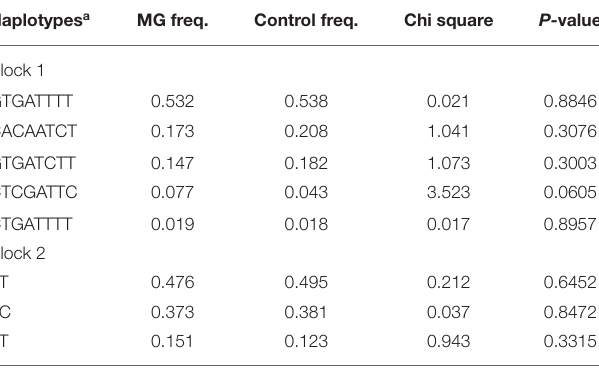
TABLE 4.2 | Haplotypes of the VDR gene between adult non-thymoma AChRAb negative MG and the control group. Haplotypes a MG freq. Control